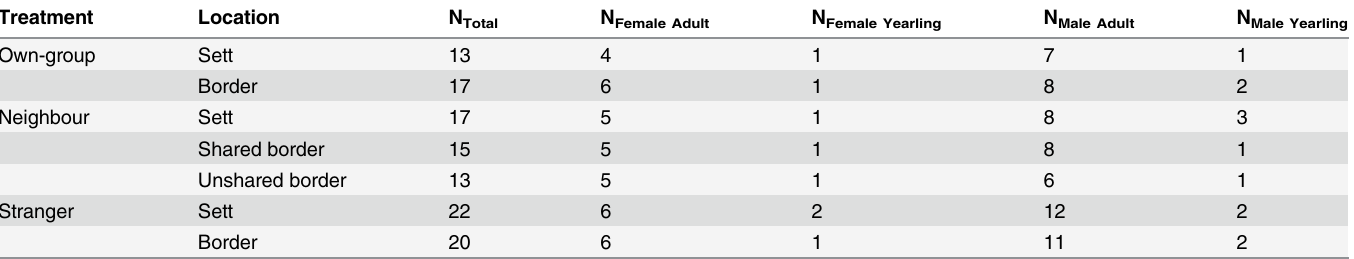
Table 1. Scent samples used in the behavioural trials varying in levels of familiarity (own- group, neighbour, stranger), spatial-context (sett, shared border, unshared border) and sex and age class of the scent donor (n = 117).